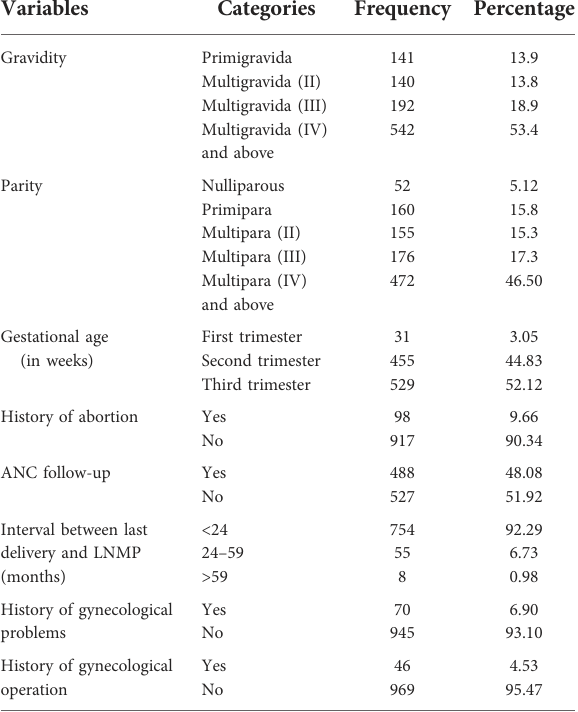
TABLE 3 Psychosocial and other substance use behavioral characteristics of pregnant women at Kersa and Haramaya HDSS sites, 2021 ( n